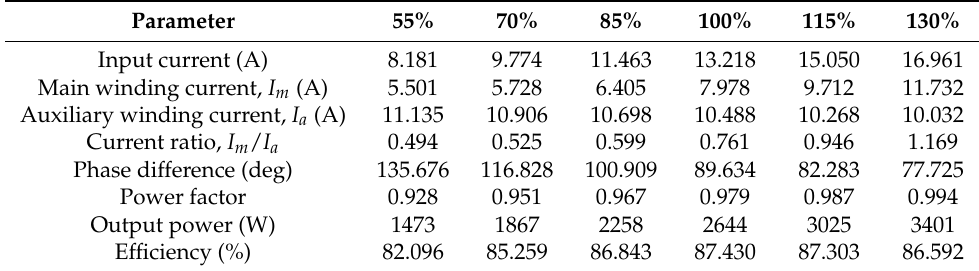
Table 4. The comparison of operating performance at different loads.